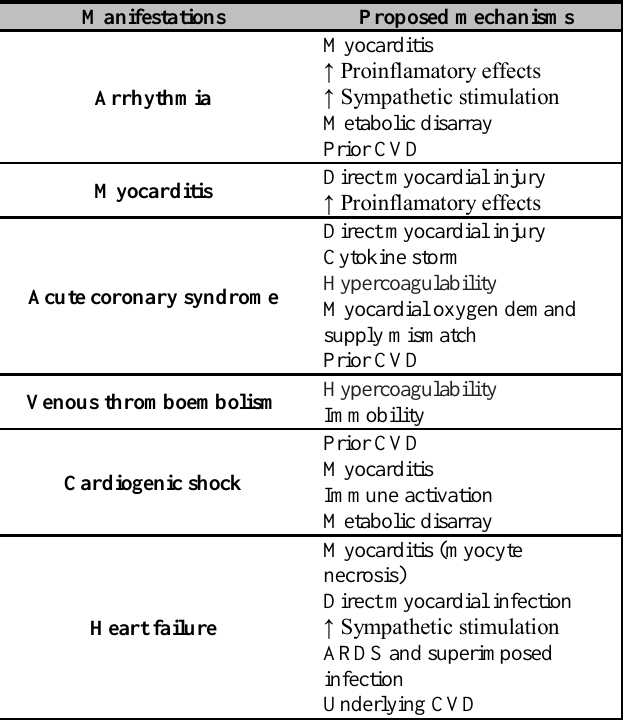
Table 1. Cardiovascular manifestation of COVID-19